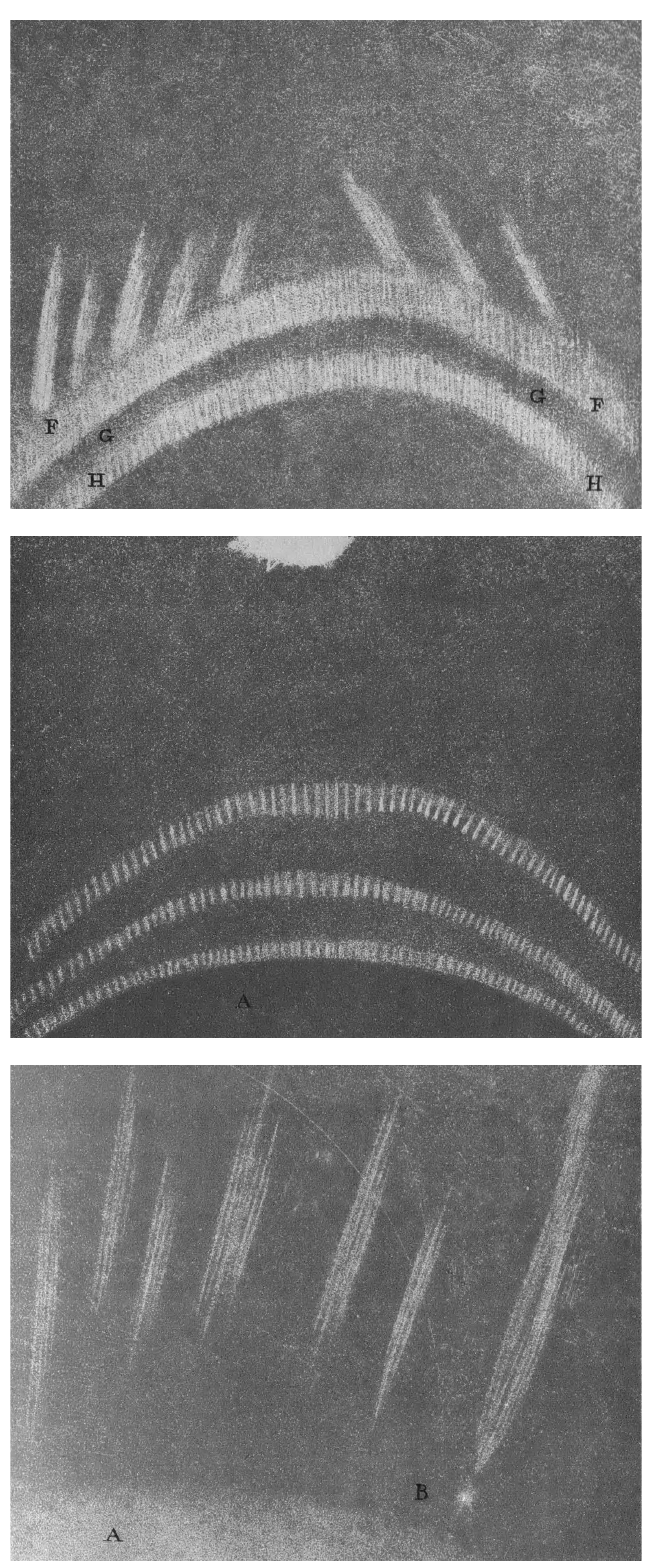
Figure 1. Drawings of various auroral types by Mikhail Vasilyevich Lomonosov.